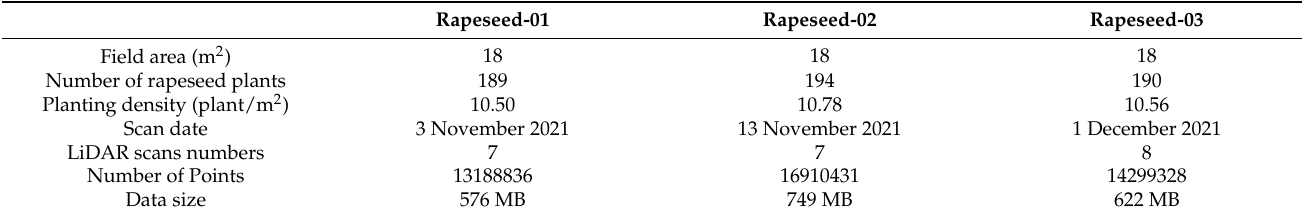
Table 1. Field point cloud property sheet.